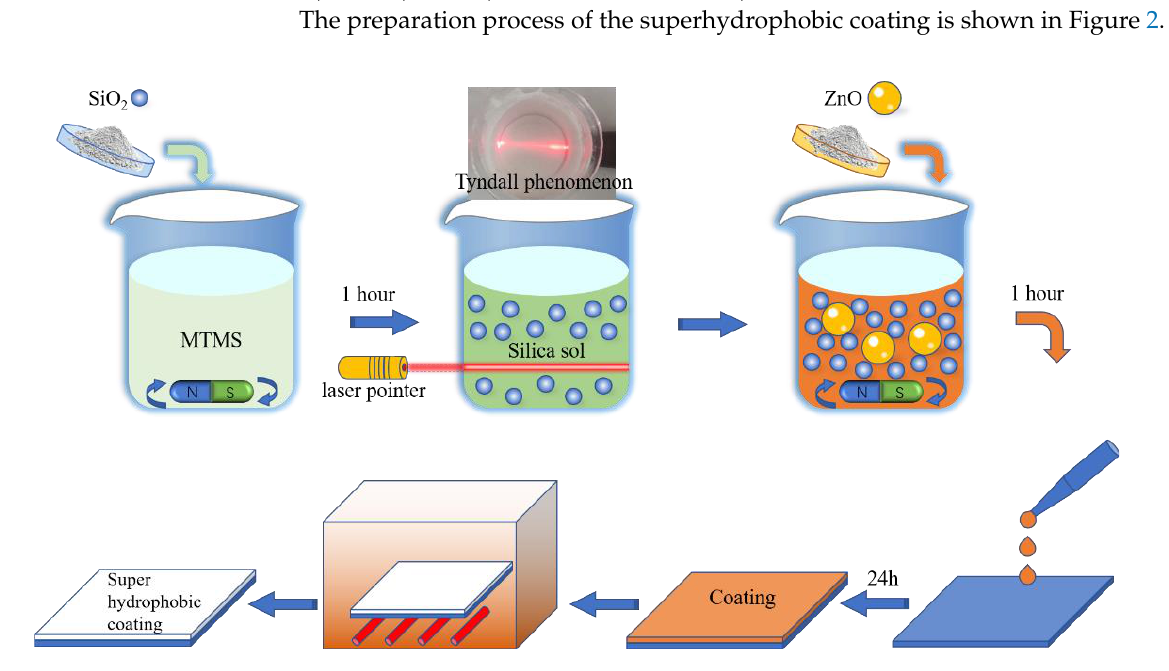
Figure 2. Diagram of coating preparation process.